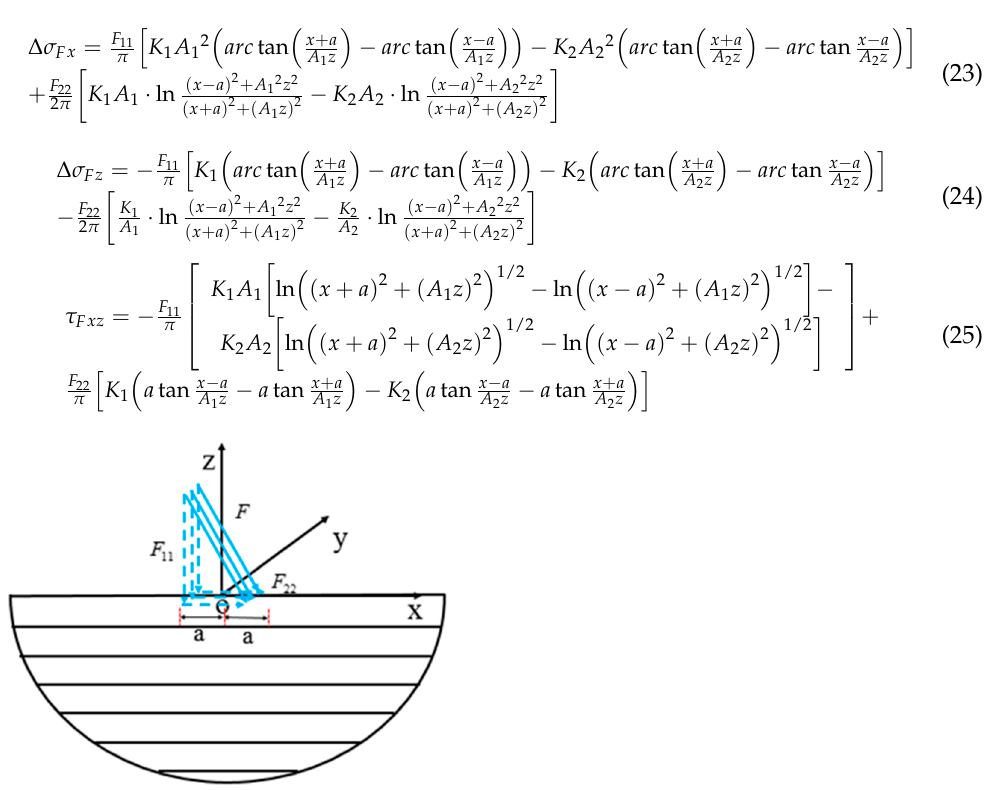
Figure 6. Transversely isotropic elastic half ‐ plane surface subjected to distributed stress in any di ‐ rection.